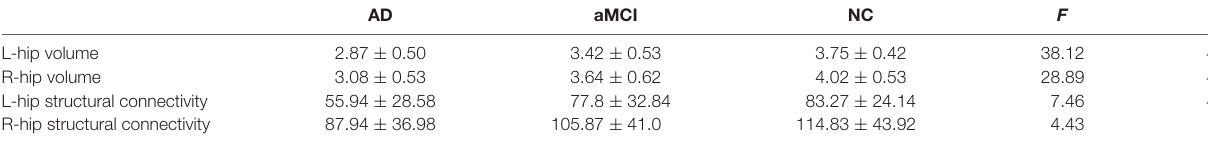
TABLE 2 | Mean volume and structural connectivity (sum of the number of connecting fibers) of the hippocampus in the AD, aMCI, and NC groups.